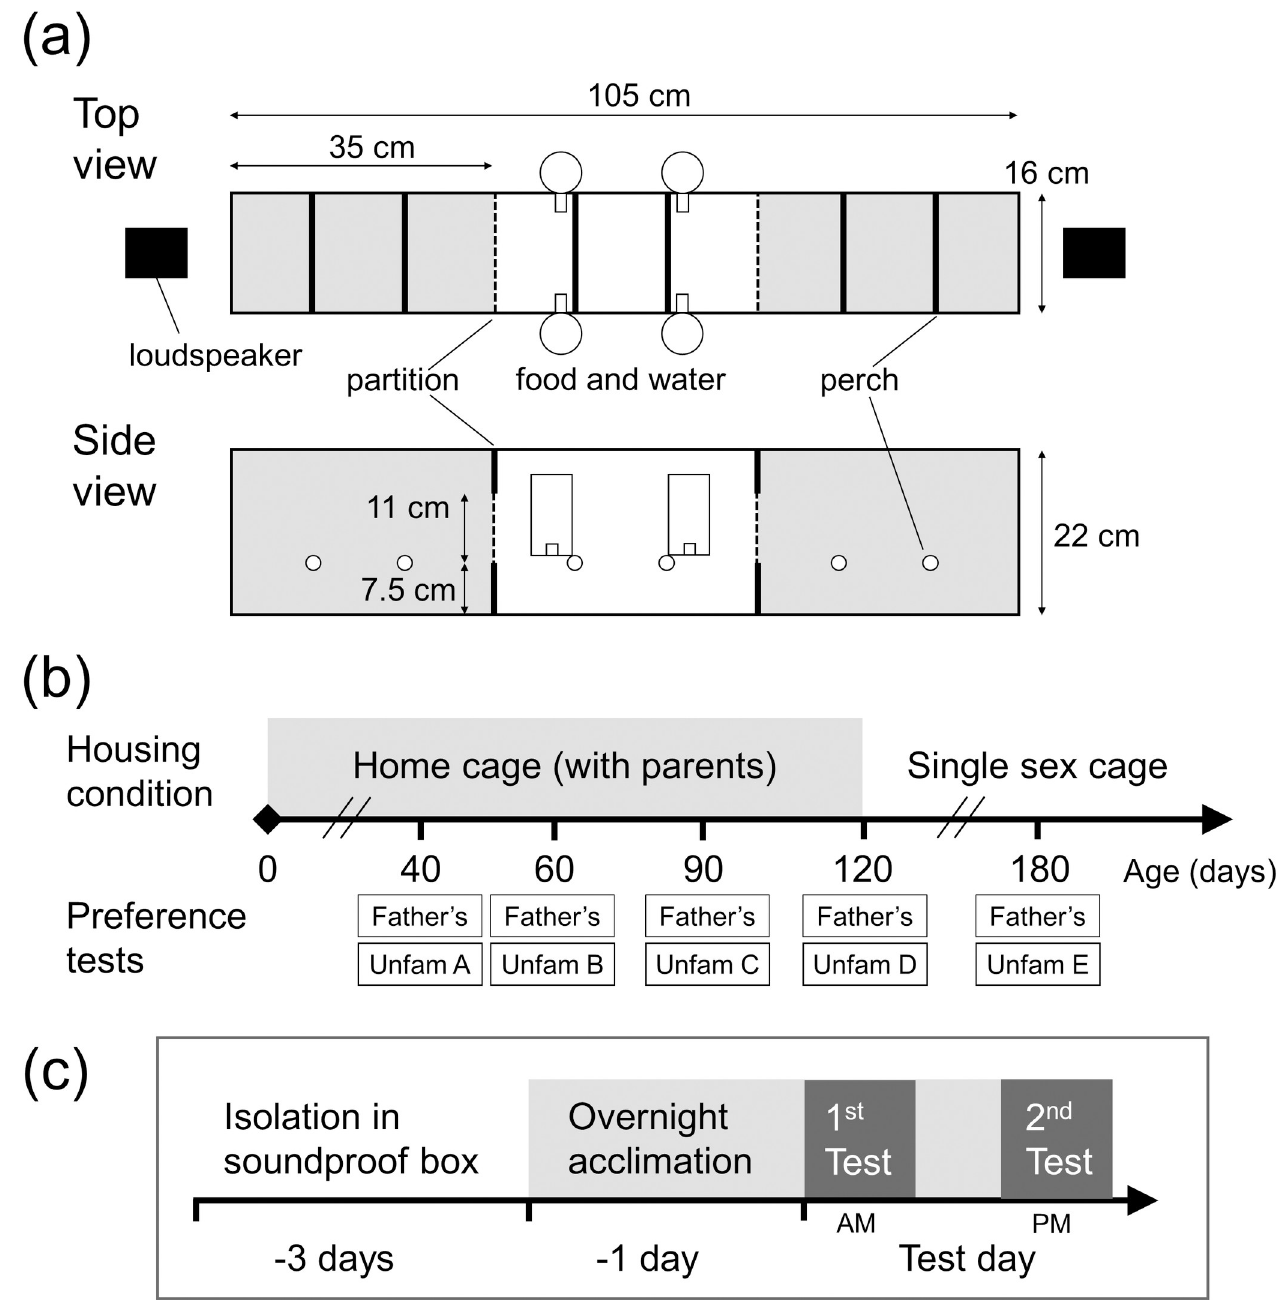
Fig 1. Overview of experimental methods. (a) A schematic diagram of the test cage. The upper and lower panels show the top and side view, respectively. Approach zones are indicated with shadings. (b) The overall time course of the experiment. (c) The schedule of a single test at a certain age. https://doi.org/10.1371/journal.pone.0243811.g001 At each age tested, we used a different individual. Thus, a bird was exposed to a new unfamiliar song at each age of testing (Fig 1B). We randomly chose which unfamiliar song to present to each bird at each age to avoid pseudo-replication and minimize any possible bias towards spe- cific songs. In some cases, a father’s song for one subject was used as an unfamiliar song for an unrelated subject hatched from another family. This was only done when the breeding period